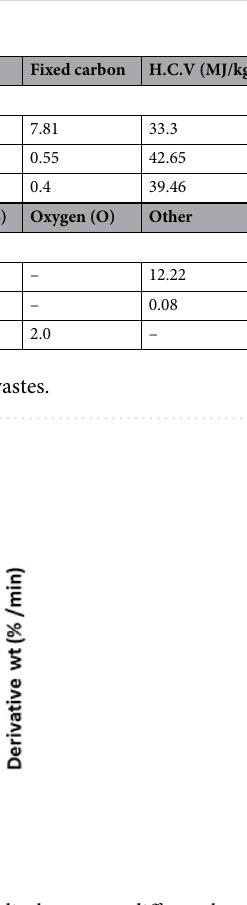
Figure 3. TG curves ( a – c ) and DTG peaks ( d – f ) of plastic based medical wastes at different heating